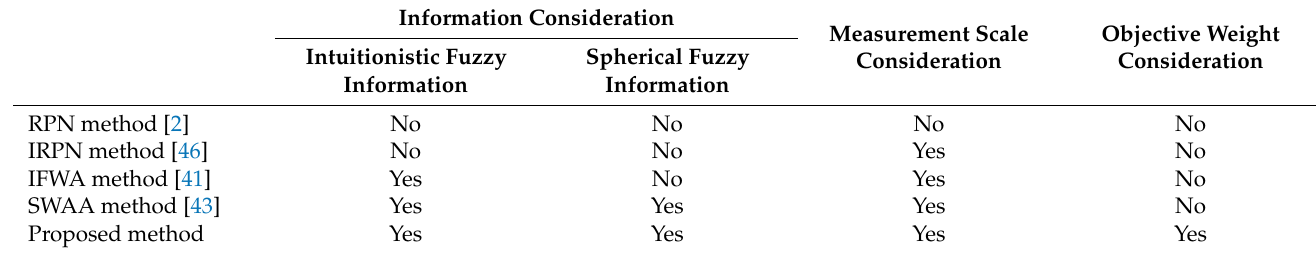
Table 9. The main differences in factors considered by different calculation